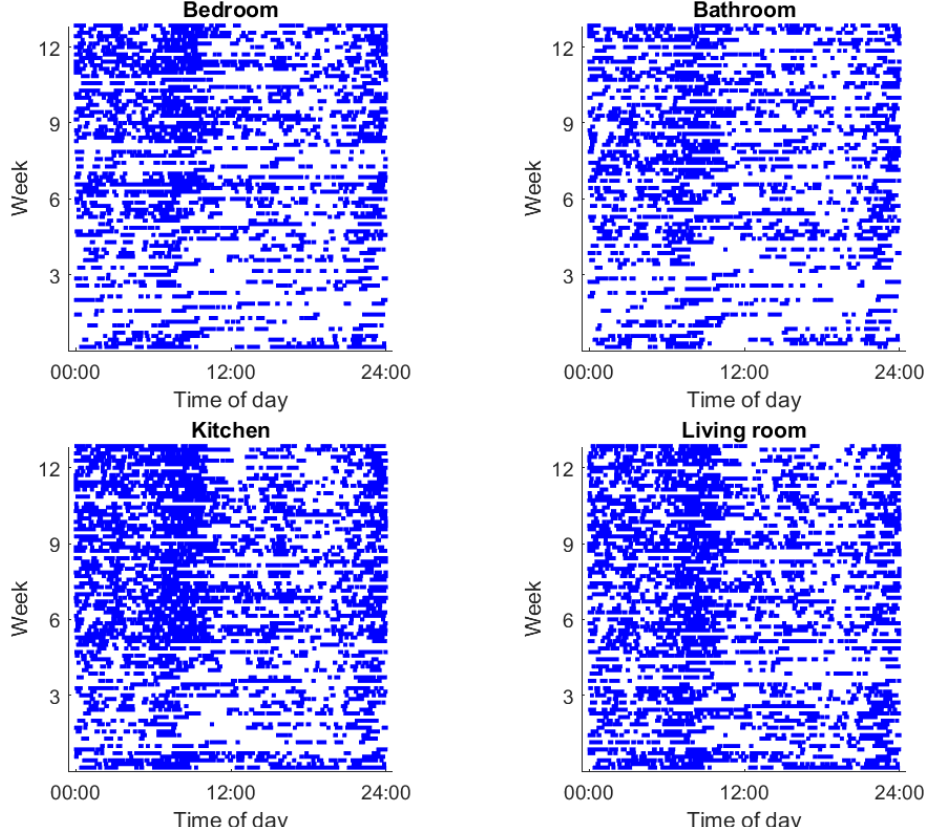
Figure 1. PIR motion sensor firings indicating motion within a given rooms, with each point recorded as a specific time and date. These observations allow for the unobtrusive determination of the times when each of these rooms within the home are occupied. Blue periods correspond to motion being detected, whereas open periods correspond to periods without motion.